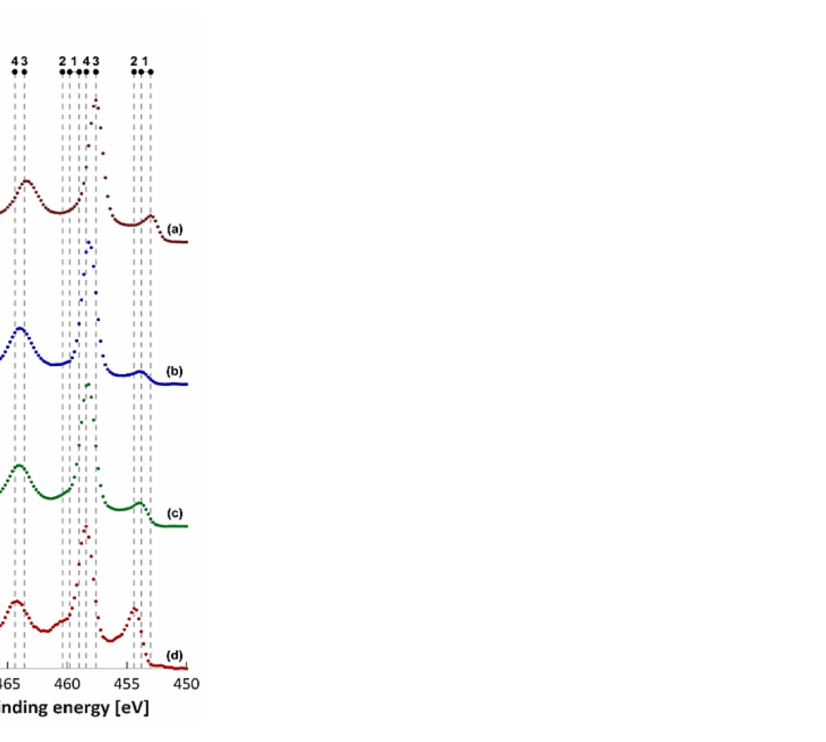
Figure 18. XPS spectra of Ti2p3/2: 1—453.0–453.8 eV, (Ti0), 2—454.4 eV (TiC), 3—458.4 eV (TiO2), 4—458.6 eV (TiO2 doped Mo6+). ( a ) Ti + 10 wt %(Ti,Mo)C, ( b ) Ti + 10 wt %(Ti,Mo)C/C, ( c ) Ti + 20 wt %(Ti,Mo)C, ( d ) Ti + 20